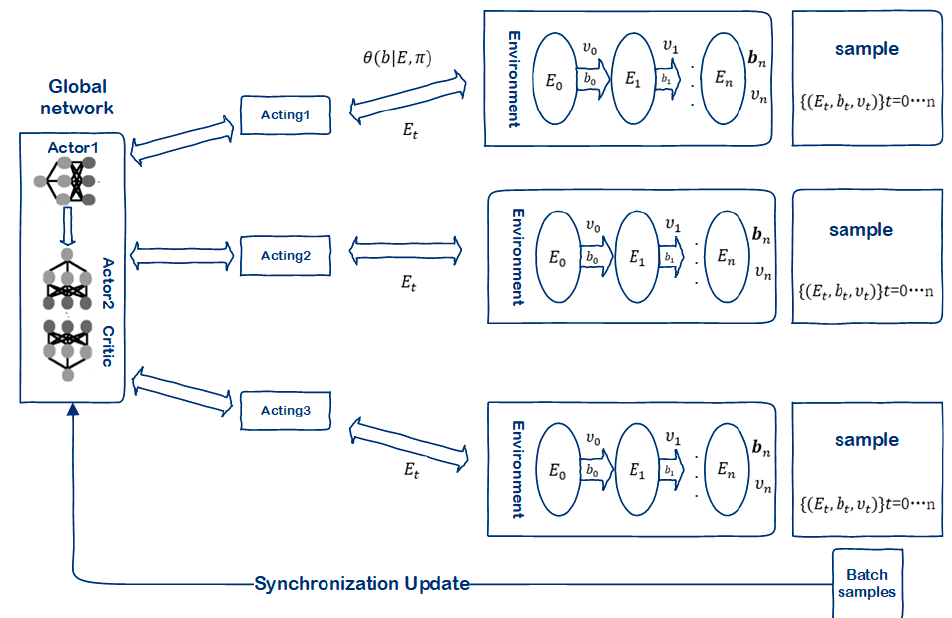
Figure 3. Restriction strategy update range indication.